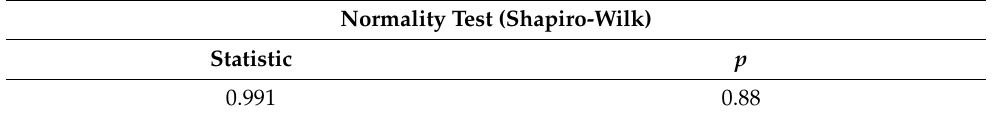
Table A6. Experimental and calculated viscosities of Haden mango peel pectin. Solution Viscosity (Pa.s)